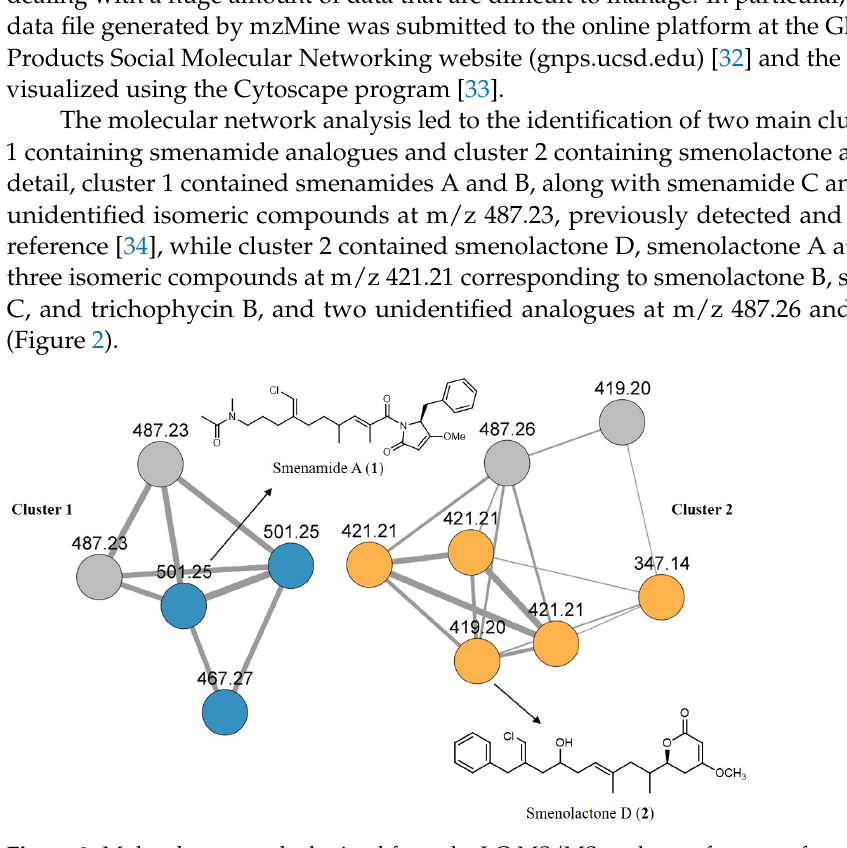
Figure 1. Single flow diagram representing the overall methodology adopted.